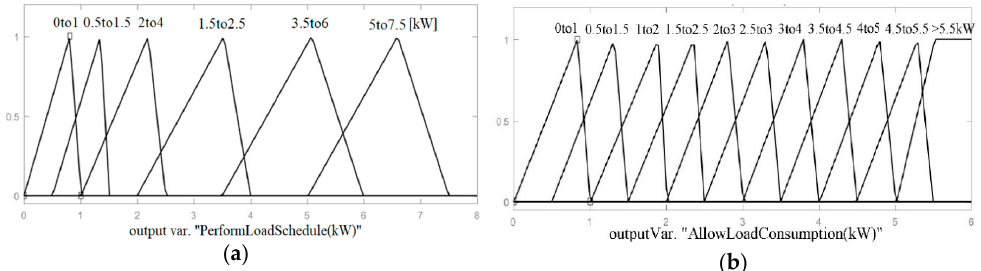
Figure 11. (Left–Right; Top–Bottom): Fuzzy input membership function for ( a ) time; ( b ) comfort preference; ( c ) temperature deviation; ( d ) forecasted demand; ( e ) consumption time; ( f ) local voltage level; ( g ) renewable energy sources (RES)_penetration; and ( h ) utility load control.